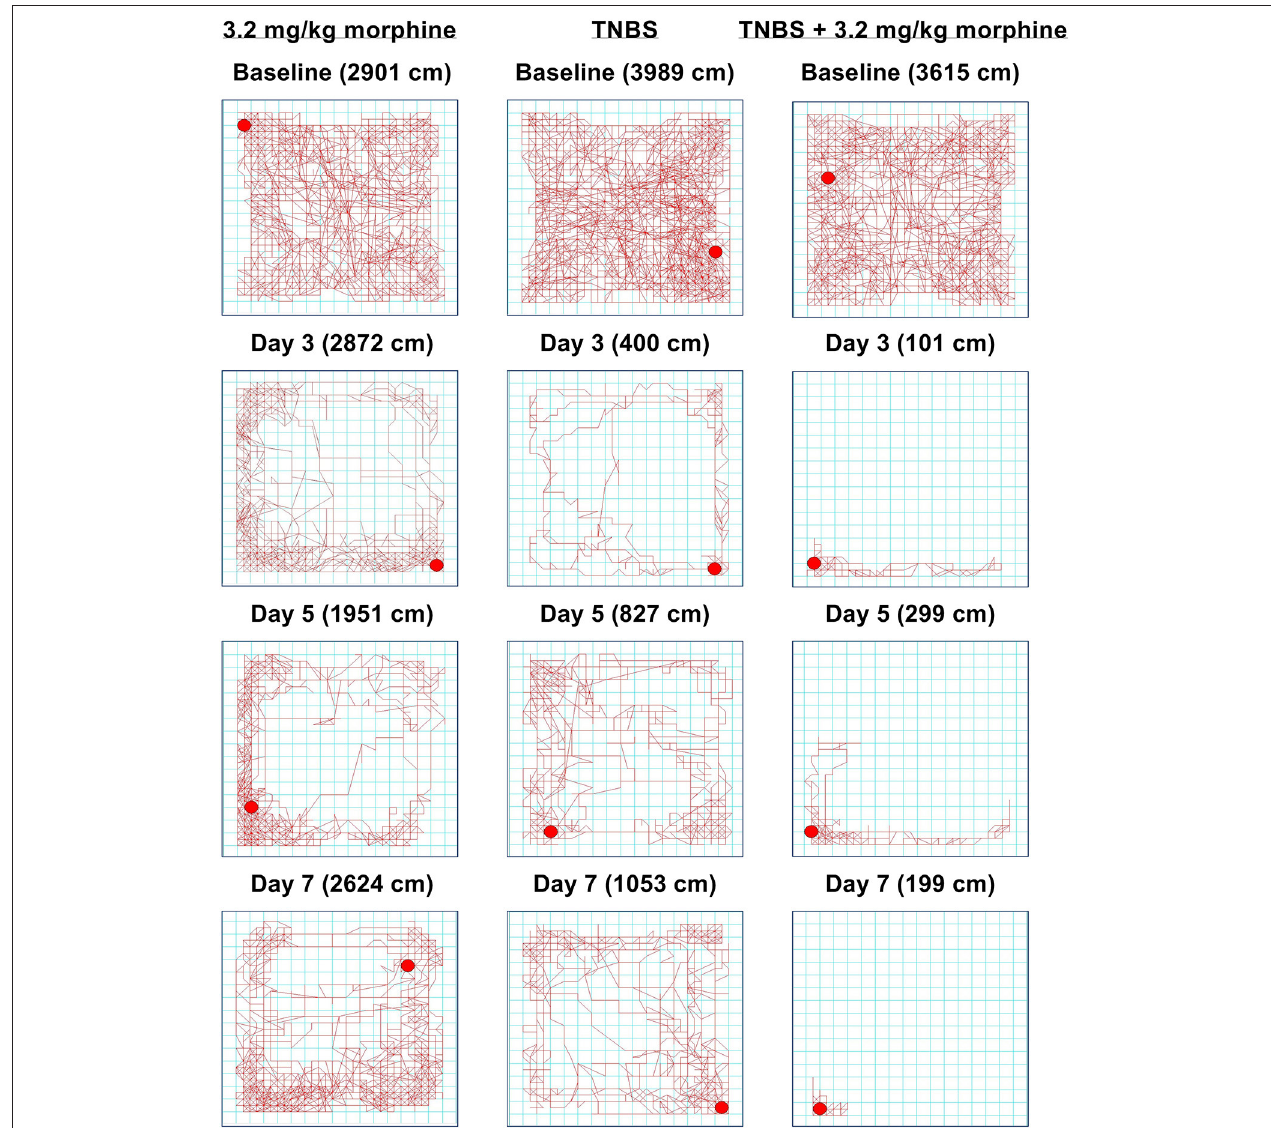
FIGURE 11 | Time-dependent effect of morphine, TNBS and their combination on spontaneous locomotor activity. Locomotor activity in mice treated with (left) 3.2 mg/kg/day morphine, (center) TNBS and (right) TNBS + 3.2 mg/kg/day morphine at baseline, Day 3, Day 5, and Day 7. Distance traveled on each day is indicated in parenthesis. 3.2 mg/kg/day morphine does not disrupt locomotion, but the mouse appears to move along the perimeter, indicating thigmotaxis. Locomotor activity in TNBS-treated mouse is significantly attenuated, but appears to recover on Day 7. In the TNBS-treated mouse, daily morphine treatment exacerbates locomotor activity and delays